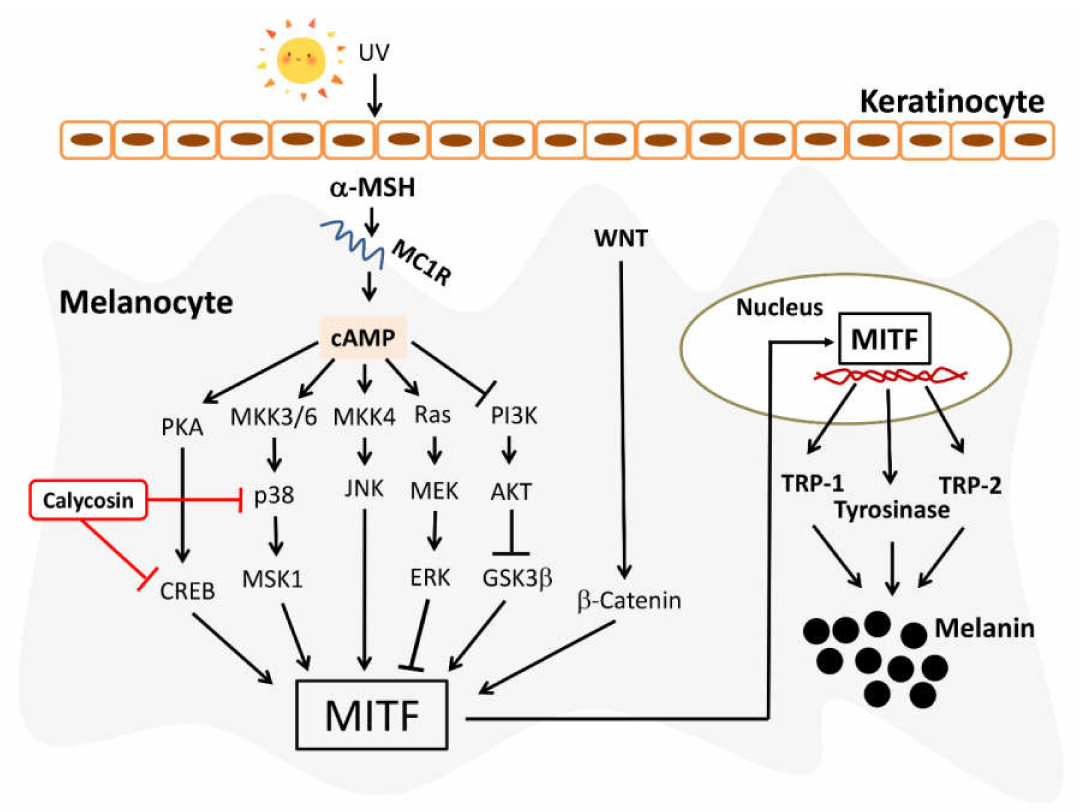
Figure 7. Proposed regulatory mechanisms of calycosin on suppression of melanin synthesis in melanocyte. The black arrows indicate stimulating signals and the red T bars indicate inhibitory